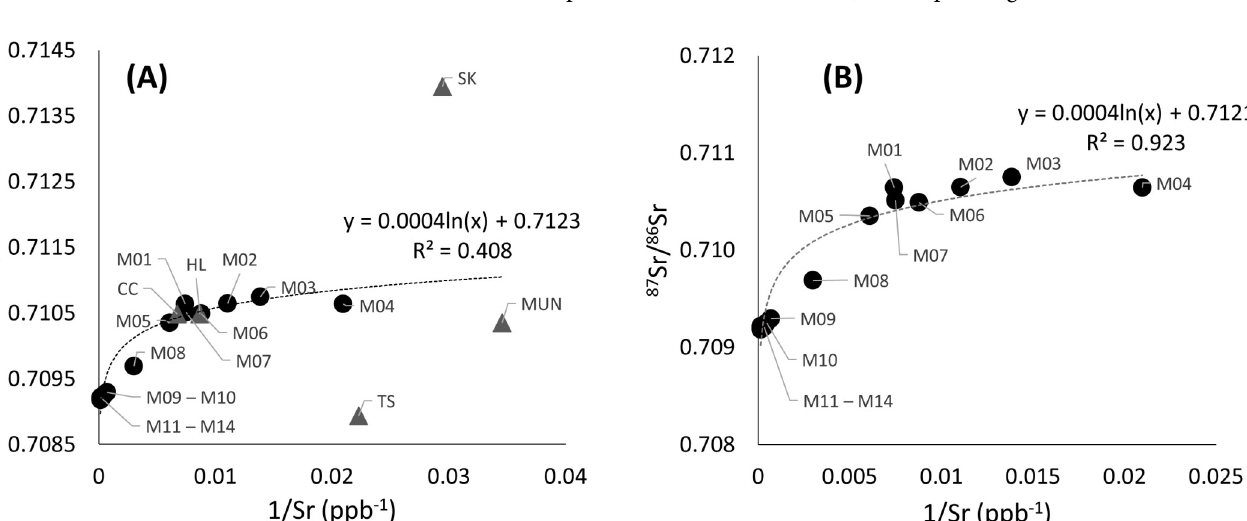
Table): high values at hatching and during the early days of life (0.7106 ± 0.0003 at the core region ~ 30 μ m width), corresponding to the 87 Sr/ 86 Sr of waters collected upstream along the Laos–Thailand border and through Cambodia (sites M01 to M04). The ratios then decreased to a more or less variable plateau (0.70928 ± 7.4 × 10 − 6 ), corresponding to the 87 Sr/ 86 Sr of the